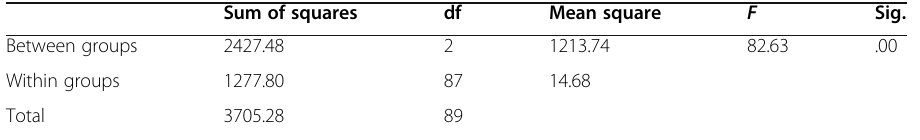
Table 10 Results of one-way ANOVA for comparing the speaking complexity post-test scores of the GDA, C-DA, and N-DA learners